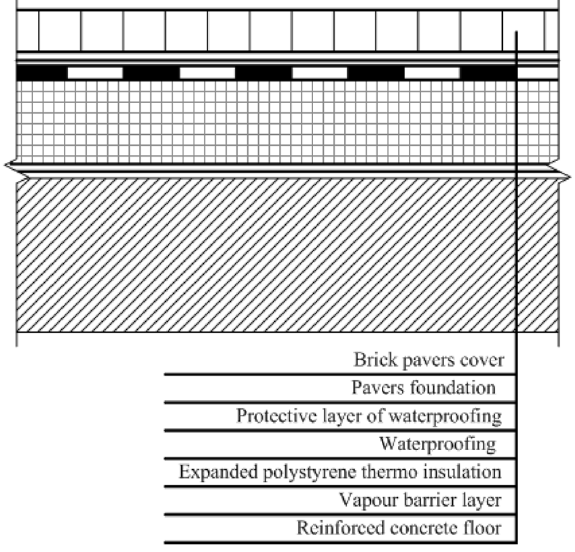
Fig. 1. Installation option of the direct exploitable roof